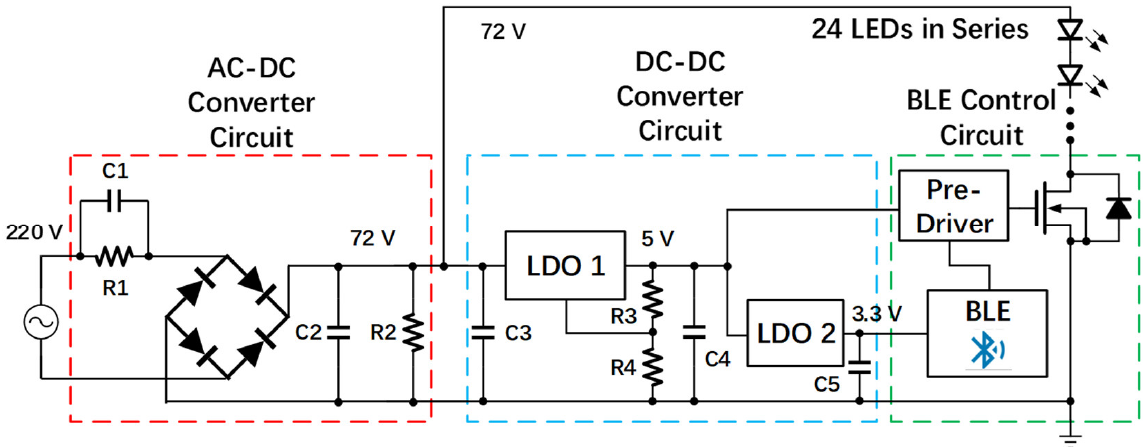
Figure 3. Schematic of high-power LED lightbulb with VLC functionality.